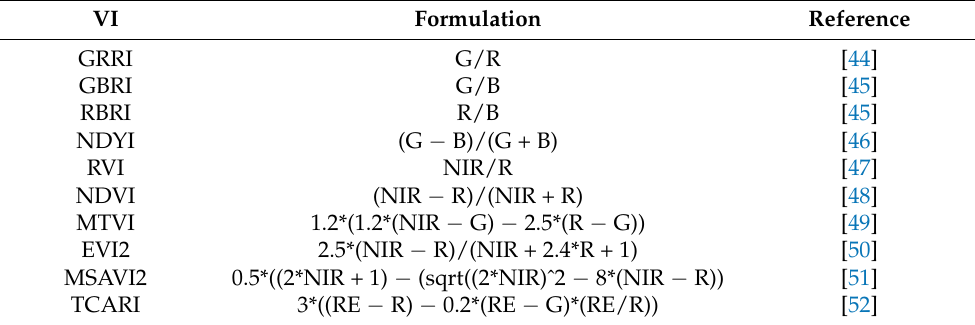
Table 1. Selected vegetation indices (VIs) for the yield prediction of the winter wheat.